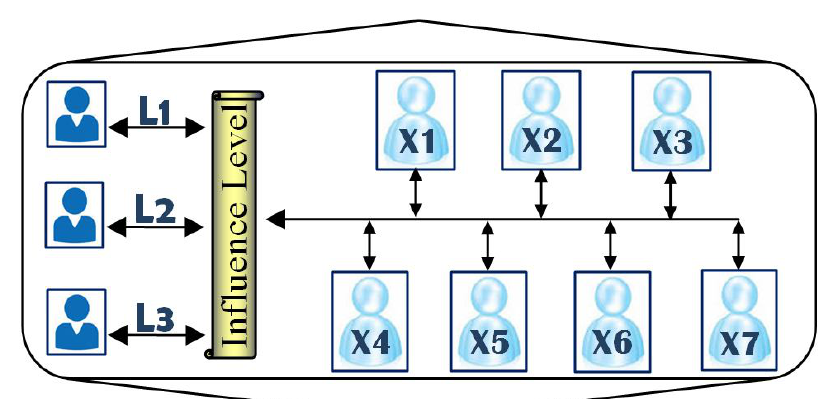
Fig. 3. Details of functional processes in operator tier of FFM considering roles ( Xi ) and position ( Li ) of operators involved in a HBs-related project